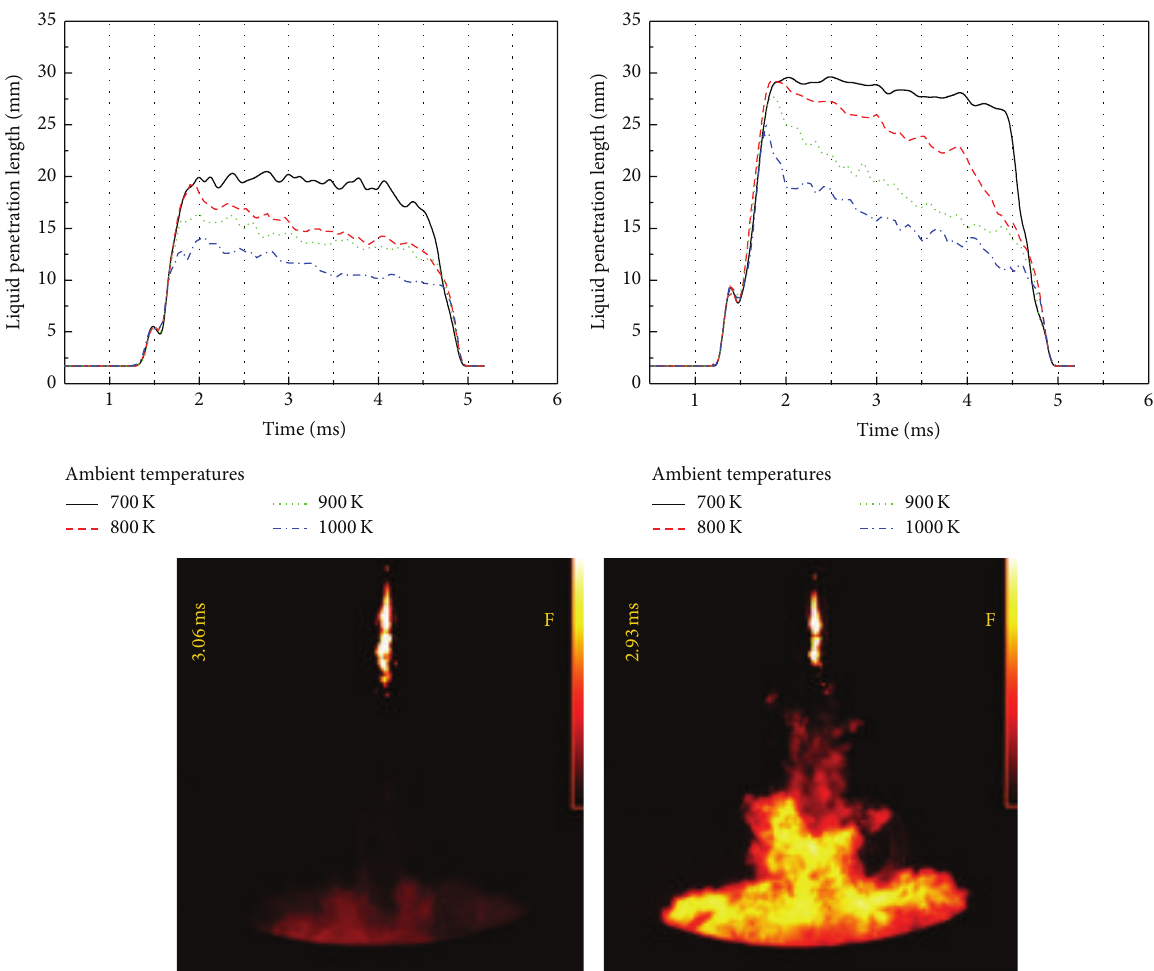
Figure 4: Liquid penetration lengths at different ambient temperatures for n-butanol and soybean biodiesel [36].